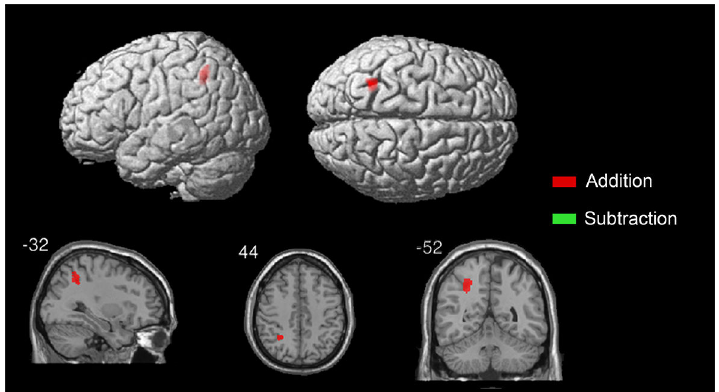
Figure 4. Areas that show activation negatively correlating with finger gnosis for addition and subtraction, masked by common regions for addition – baseline and subtraction – baseline contrasts. Only one inferior parietal cluster, negatively correlating with finger gnosis for addition was significant (141 voxels, MNI: 26 -48